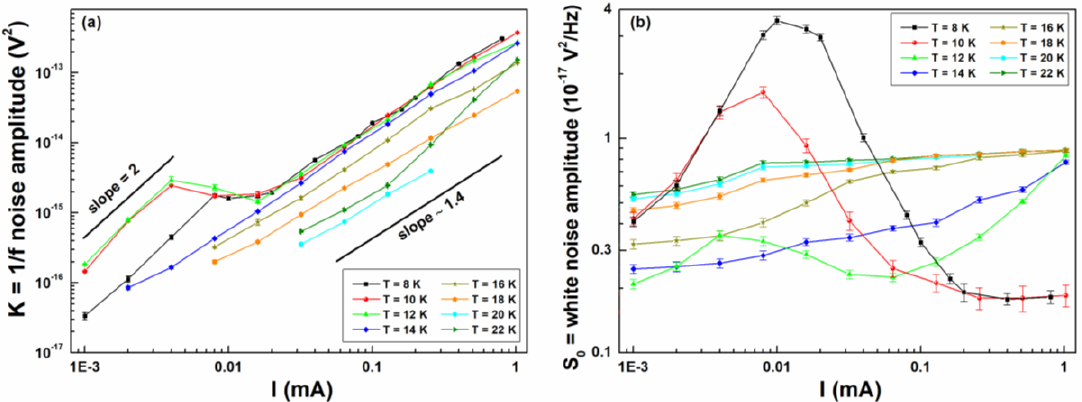
Figure 6. Electric noise amplitudes behavior. The dependencies on bias current, and at several temperatures, are shown for the 1/ f ( a ) and for the “white” ( b ) noise components, respectively.